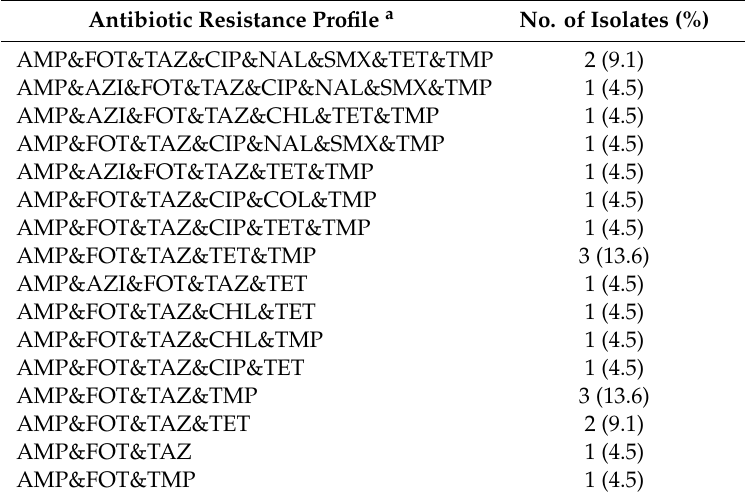
Table 6. Number and percentage of cefotaxime-resistant E. coli isolates resistant to the antibiotics tested in the EUVSEC